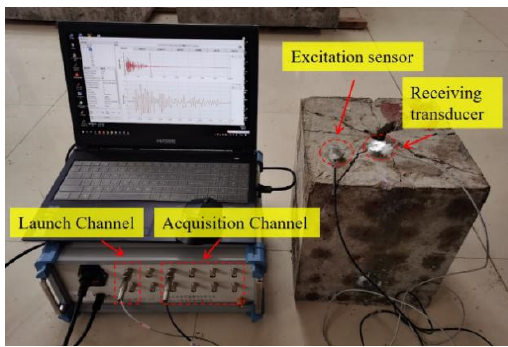
Figure 5. Multifunctional piezoelectric signal-detection and -analysis system.